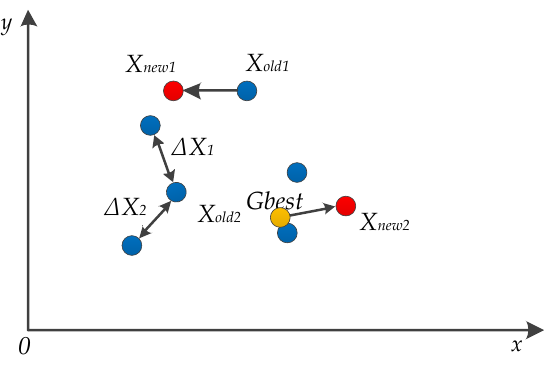
Figure 1. Two ways for updating the second new solution generation. Table 1. Self-adaptive technique for the second update of new solutions.